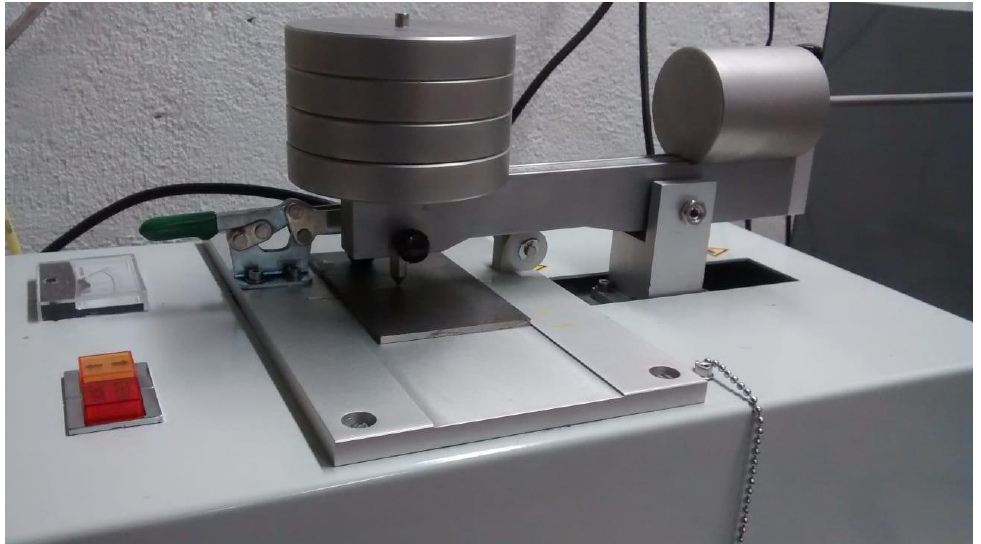
Figure 2. Clemen Scratch tester with a 4 kg load.